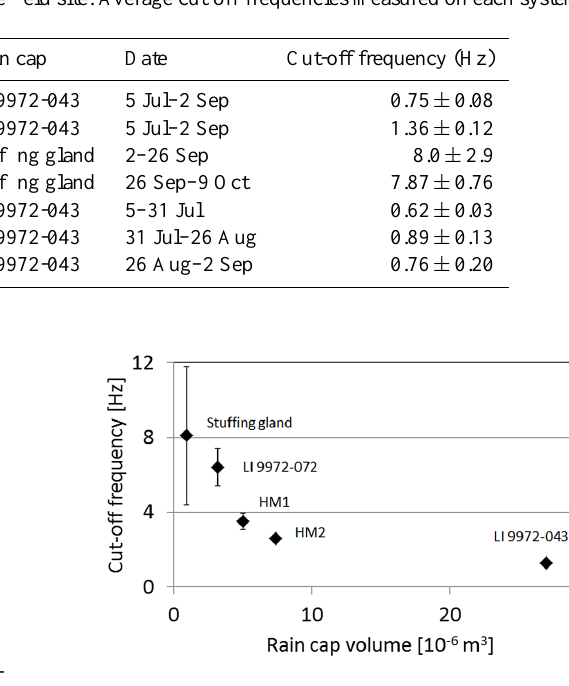
Figure 6. Relation between GSS cut-off frequency at a 15Lmin − 1 flow rate and rain cap